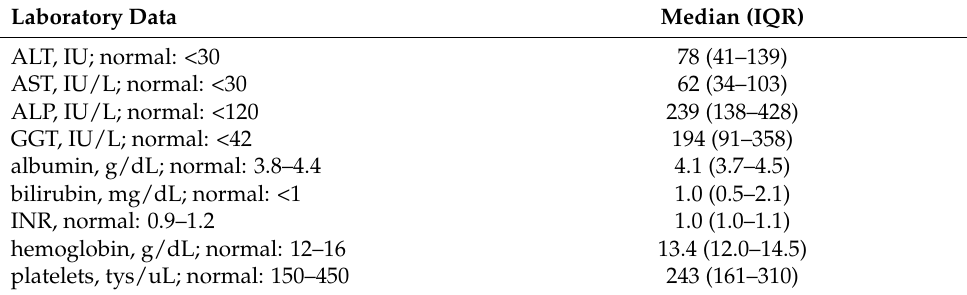
Table A1. Laboratory data of 309 patients with primary sclerosing cholangitis. Abbreviations: ala- nine aminotransferase, ALT; alkaline phosphatase, ALP; aspartate aminotransferase, AST; gamma glutamyltransferase, GGT; inflammatory bowel disease, IBD; international ratio,